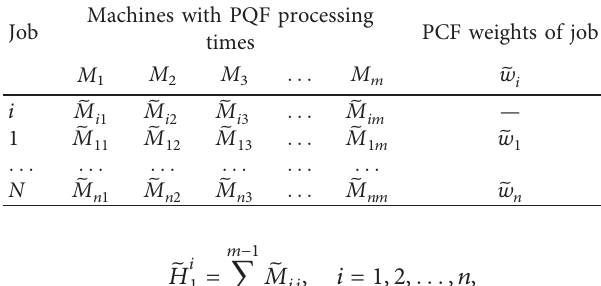
1: Piecewise quadratic fuzzy